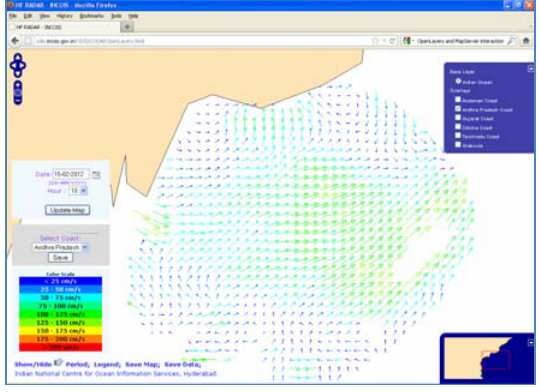
Figure 5. Visualisation of the surface currents from the HF Radar